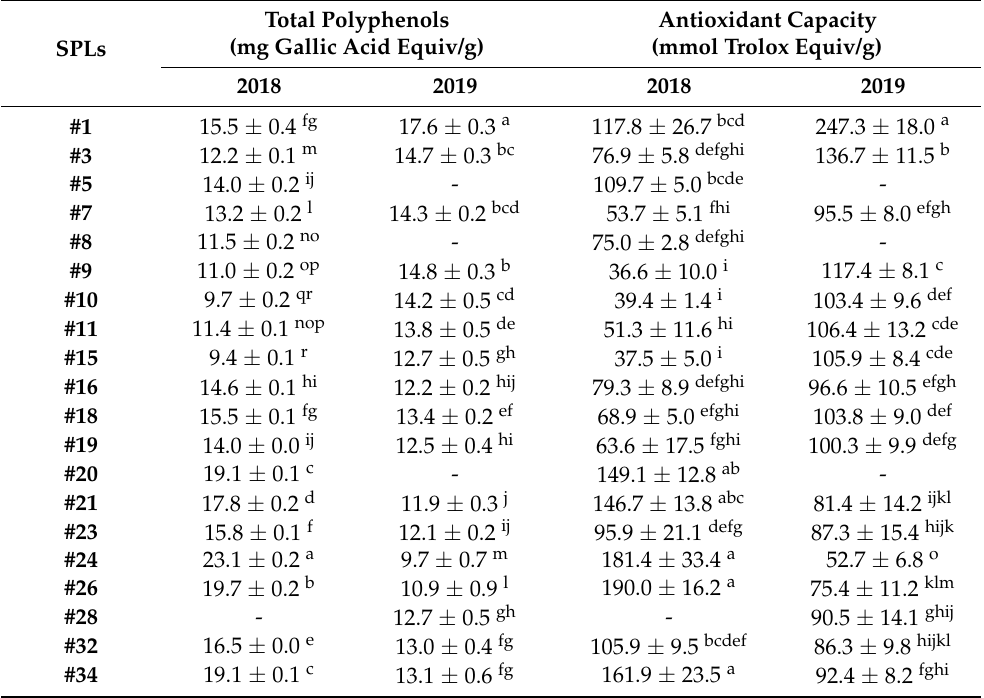
Table 1. Total polyphenols and antioxidant capacity of sweet potato leaves (SPL).